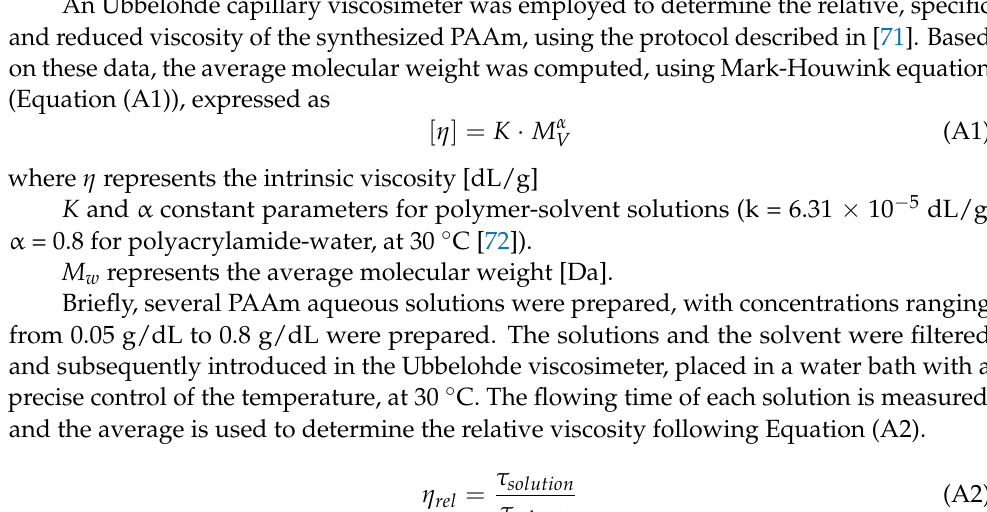
Supplementary Figure S3: Relevant SEM images of the PAC freeze-dried samples, indicating the smooth surface of the pores’